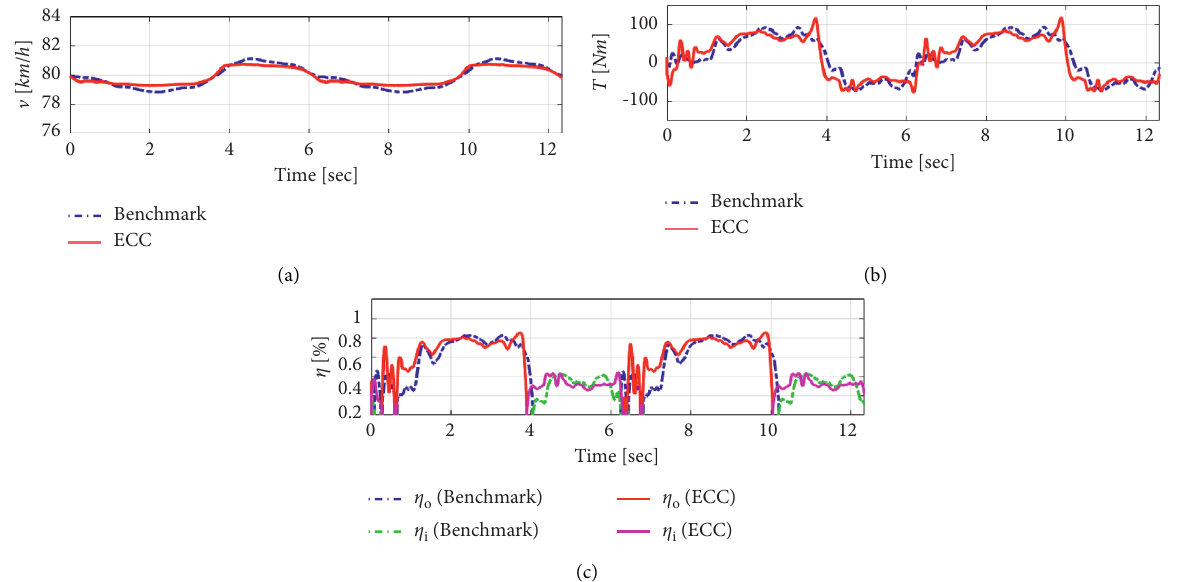
Figure 11: Control performances and comparison of ECC and benchmarked cruise control. (a) Vehicle speed. (b) Motor’s torque. (c) Motor’s efficiency. Table 3: Motor’s average efficiency and ride comfort by the benchmarked cruise control and the proposed ECC (80km/h). Control performances